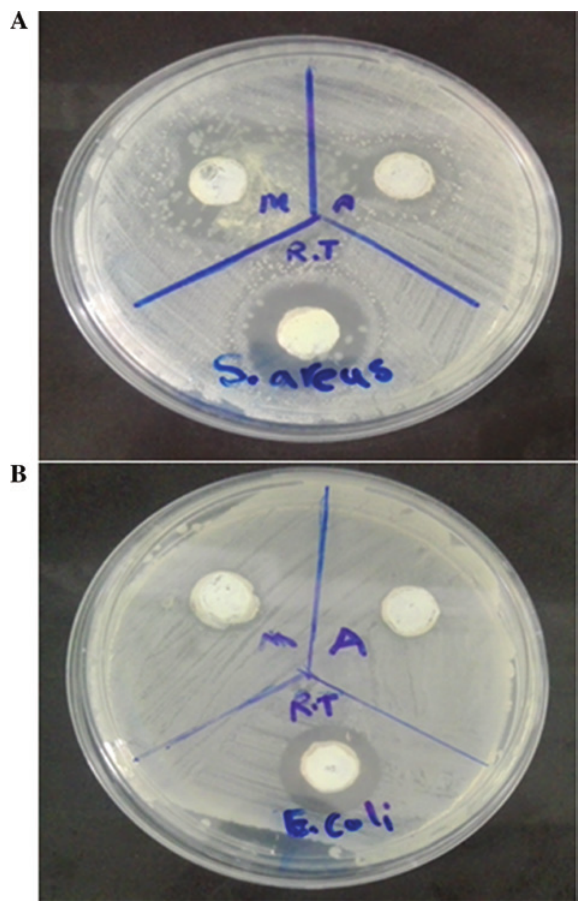
Figure 4: Antibacterial activities of the fabricated ZnO NPs using Pelargonium leaf extract and three heating methods to Staphylococcus aureus (A) and Escherichia coli